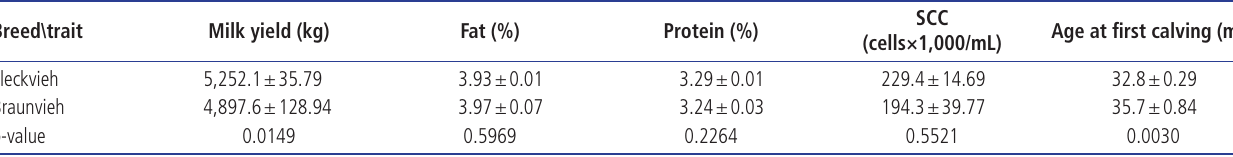
SEM, standard error of the mean; SCC, somatic cells